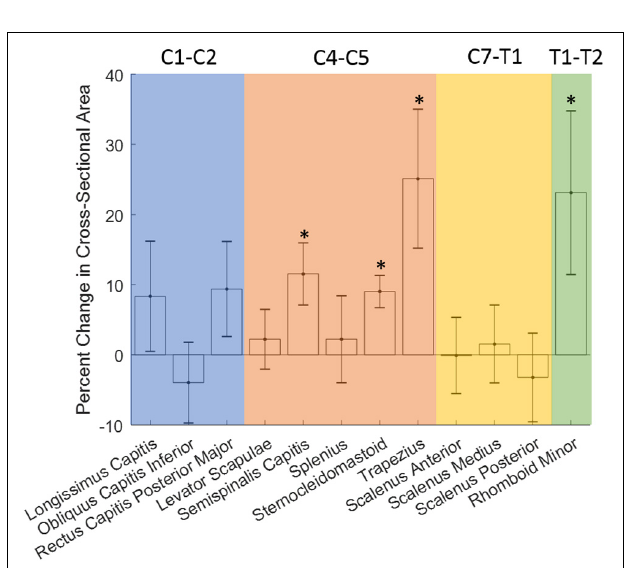
FIGURE 4 | Changes in neck muscle cross-sectional area (CSA) with long-duration spaceflight. Error bar denotes standard error. ∗ Denotes significance with p <